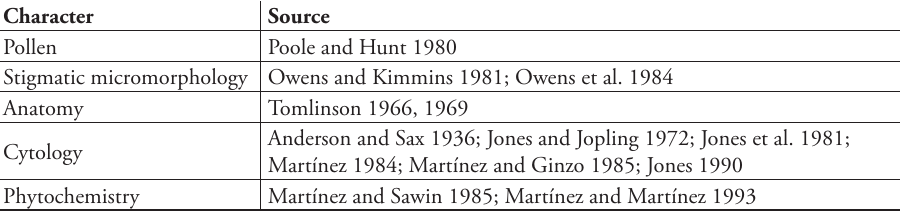
Figure 1. Some macromorphological characters used in the phylogenetic analysis. A subpetiolate leaf (Character 8) and asymmetrical base (Character 16), in Tradescantia tenella Kunth B complicate leaves (Character 8), in Tradescantia crassula Link & Otto. C impressed secondary veins (Character 19), in Tradescantia fluminensis Vell D predominantly axillar to thyrse-like synflorescence (Character 24), in Cal- lisia repens (Jacq.) L. E synflorescence with two paraclades (Character 26), in Tradescantia zanonia (L.) Sw. F contracted cincinni (Character 34), fused back to back (Character 35), vestigial cincinni bracts (Character 38), flower display of 60° (Character 48), shorter antesepalous stamens (Character 72), sig- moid filaments (Character 73), and zygomorphic androecium (Character 76), in Tripogandra diuretica (Mart.) Handlos G supernumerary cincinni bracts (Character 37), in Tradescantia praetermissa M.Pell H cincinni bracts saccate at base (Character 43), tubular flower (Character 47), fused petals (Character 60), clawed petals (Character 62), shorter antesepalous stamens (Character 72), connective expanded and transversally linear (Characters 77–80), round anther sacs (Characters 81–82), pollen white in vivo (Char- acter 83), and trilobate stigma (Character 91), in Tradescantia zebrina Heynh. ex Bosse. I tubular flower (Character 47), pedicels geniculate at anthesis and pre-anthesis (Character 51), fused sepals